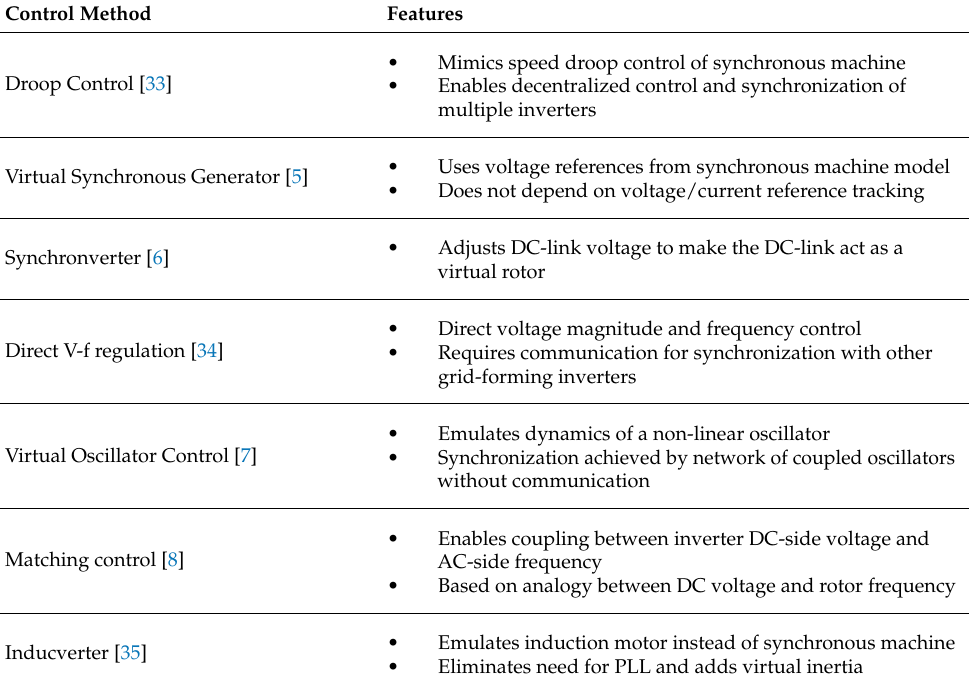
Table 1. Grid and controller